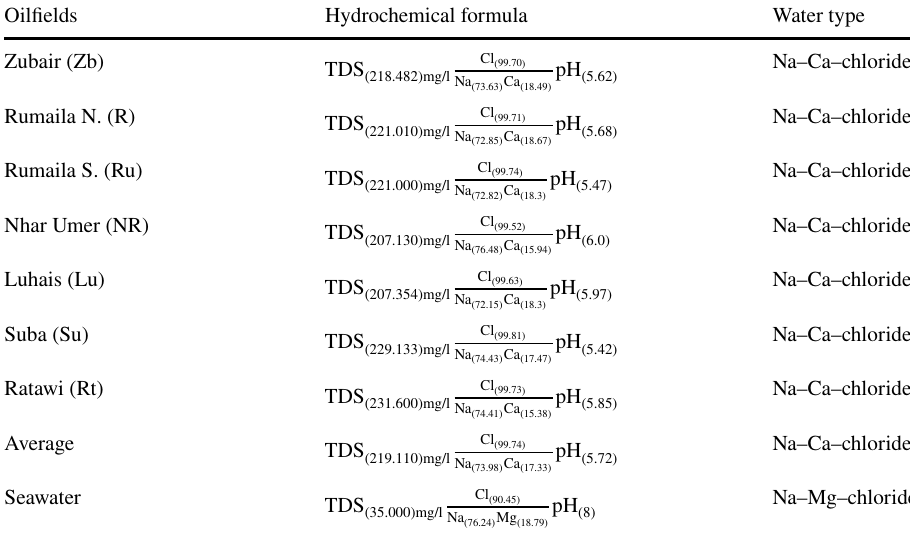
of the Zubair brines in the studied oilfields compared